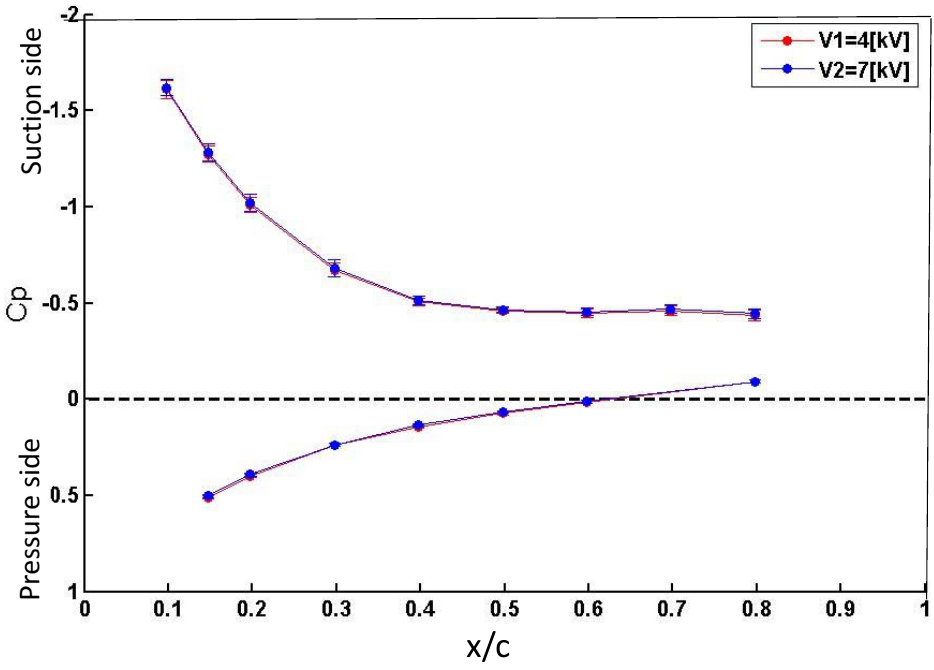
Figure 20. C p distribution comparing applied voltages at Re = 200,000 and α = 16 ◦ , and actuation frequency f = 174.4Hz.